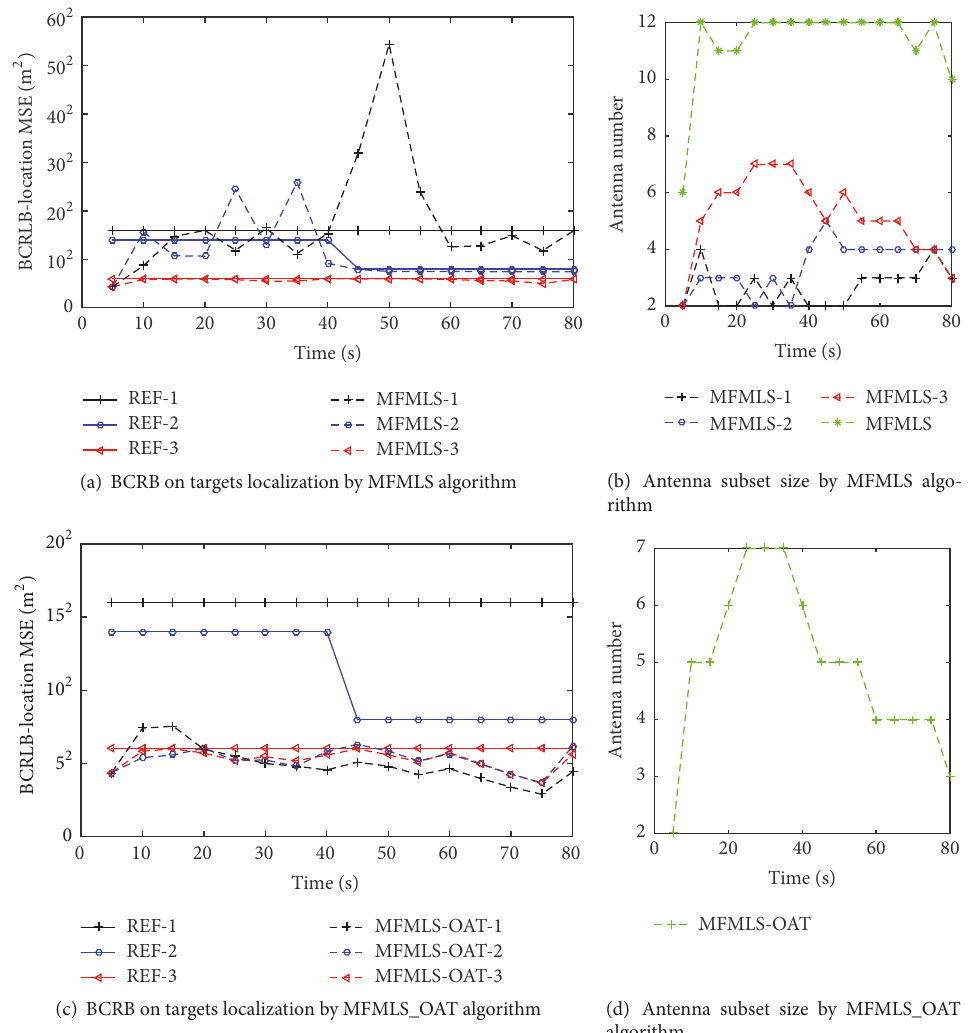
(c) BCRB on targets localization by MFMLS_OAT algorithm (d) Antenna subset size by MFMLS_OAT algorithm Figure 5: BCRB on targets localization and antenna subsets by different algorithms with low MSE thresholds.